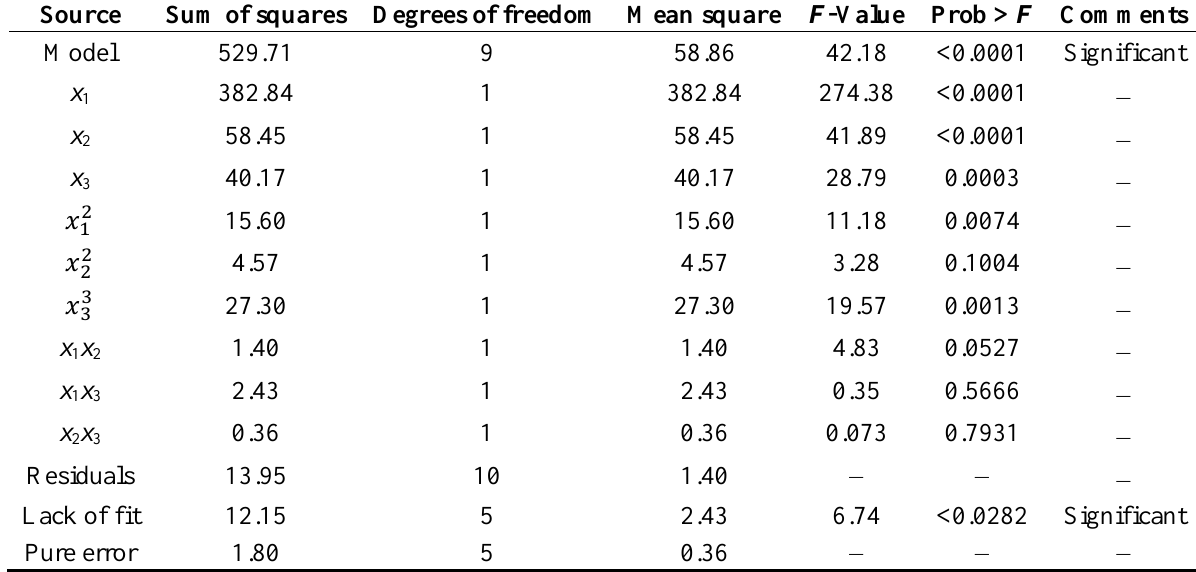
Table 3. ANOVA analysis and lack of fit test for the response surface model for the percentage yield ( y 2